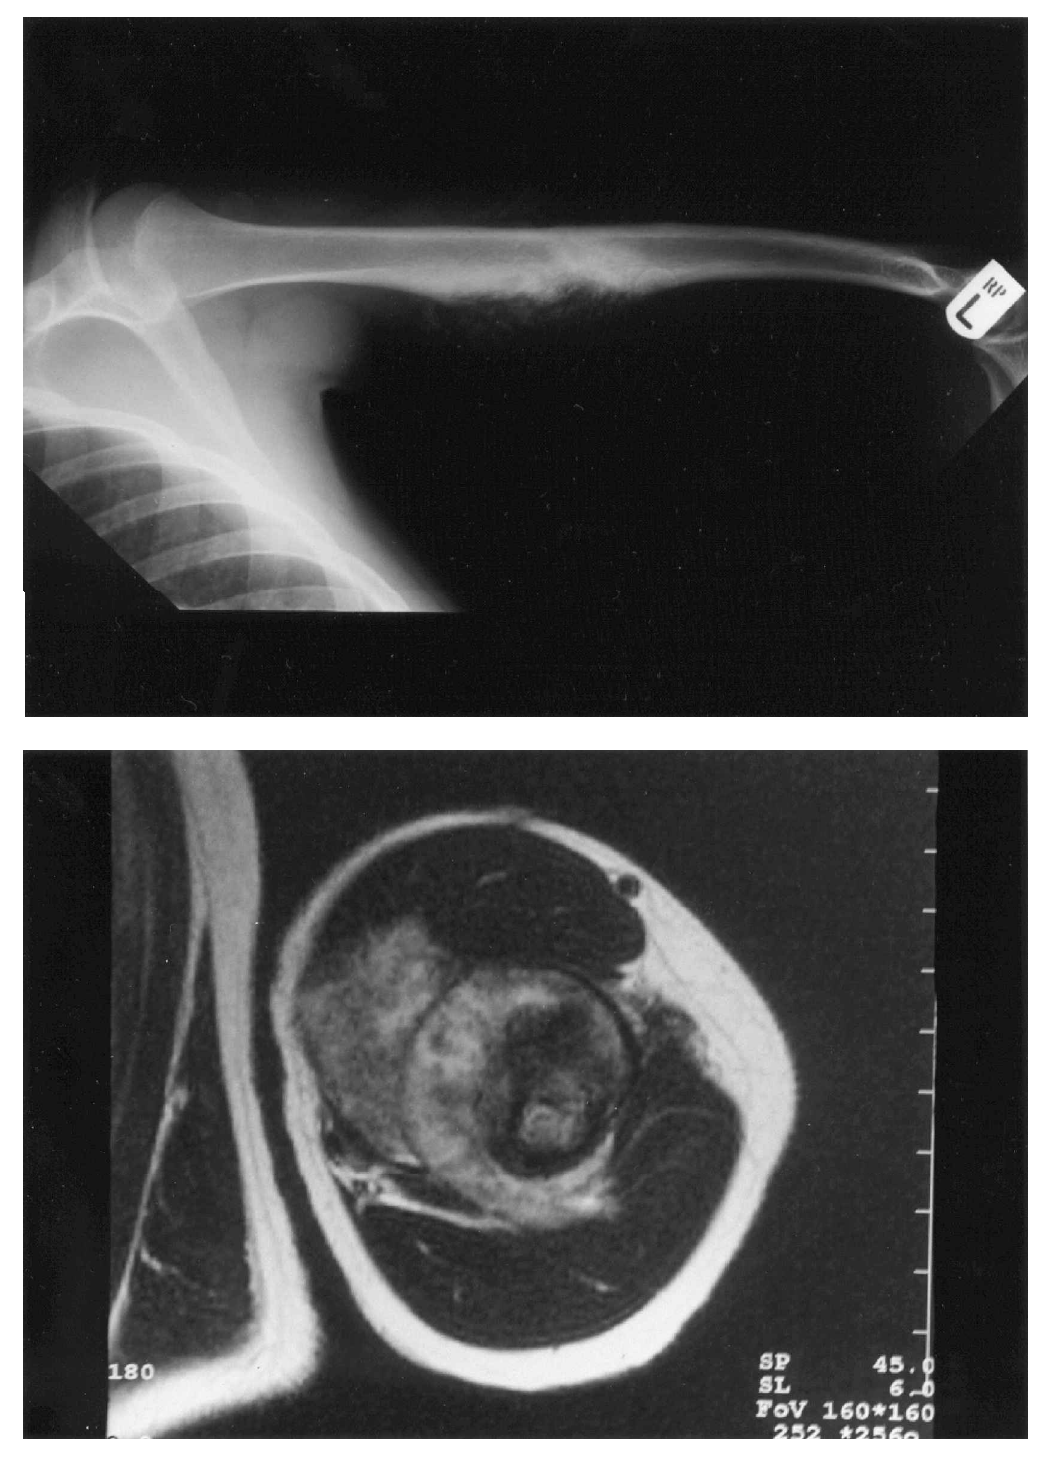
Fig. 2. (a) Plain radiograph of a humerus showing many typical features of a periosteal osteosarcoma in the diaphyseal region. (b) Magnetic resonance image of the same tumour, showing eccentric epicentre and near